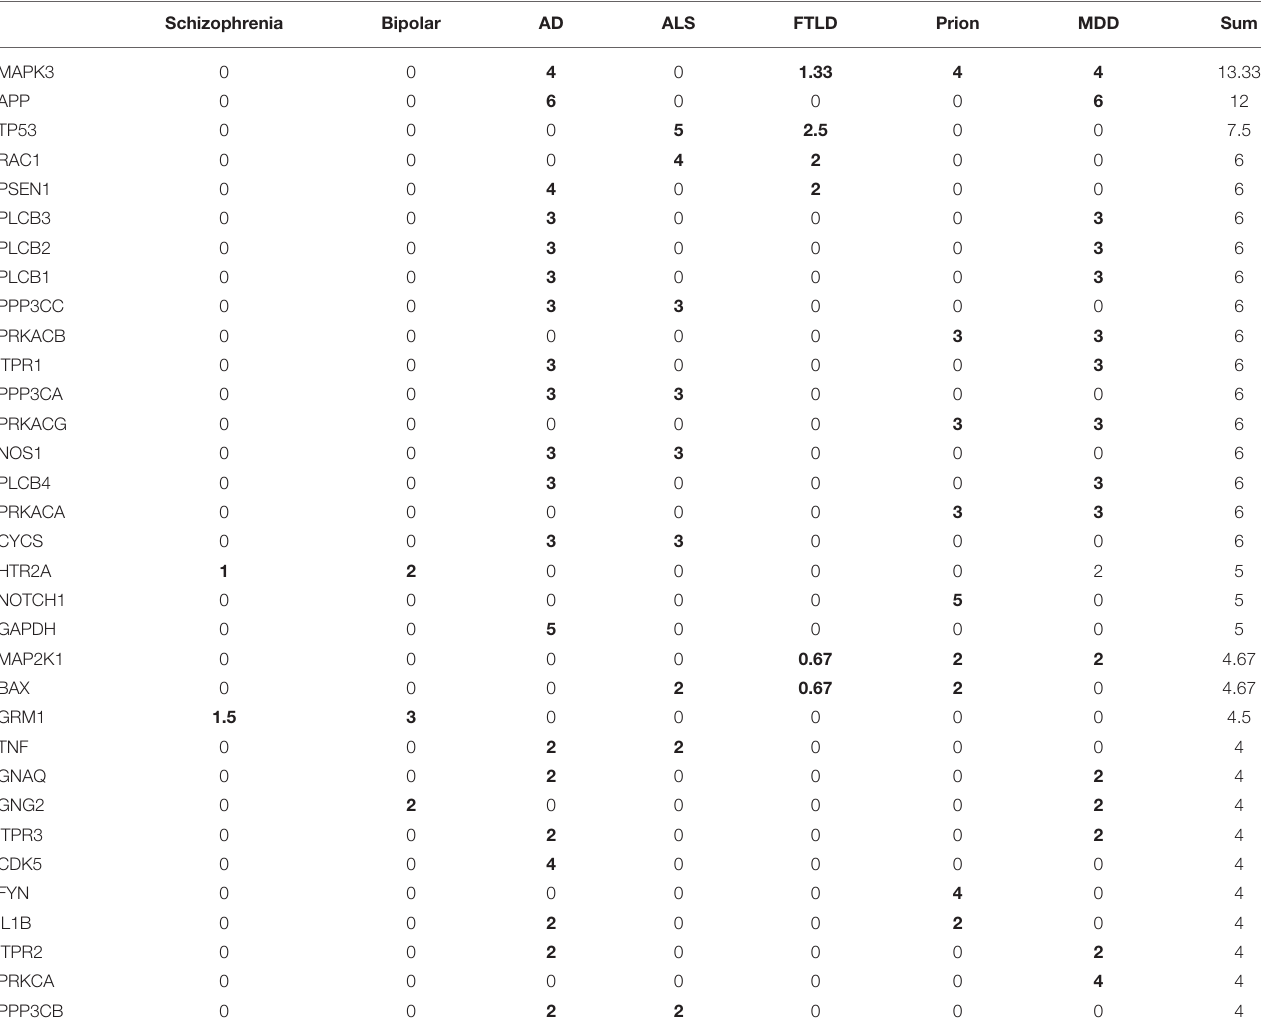
TABLE 3 | Gene counts normalized by pathway number for genes appearing at intersection of interactomes and pathways. Schizophrenia Bipolar AD ALS FTLD Prion MDD Sum